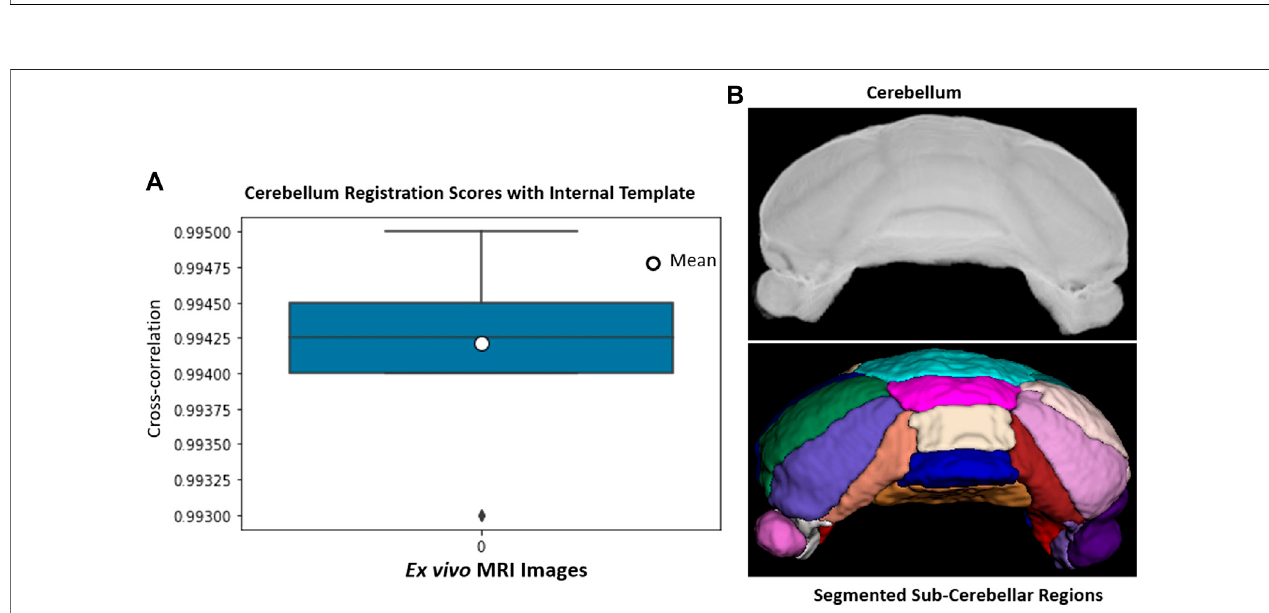
FIGURE10|(A) : Exvivo cerebellumregistration:Registrationscoresfor14cerebellumimagevolumes. (B) :Asamplevolumeandsegmentedsubcerebellarregion surfaces. Each region is delineated with separate color; Vermis IV/V (cyan), Vermis VI (pink), Vermis VII (wheat), Vermis VIII (blue), Vermis IX (golden), Simple lobe (green and white), Crus I (navy, orchid), Crus II (salmon, maroon), Para fl occulus (purple, dark